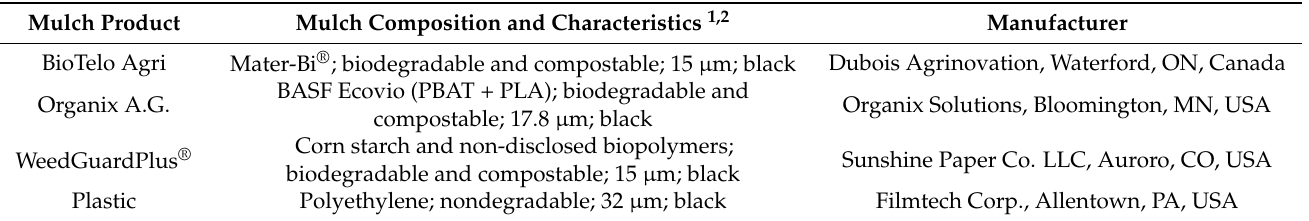
Table 1. Product name, composition, and manufacturer information of the four types of mulch films used in this study. Mulch